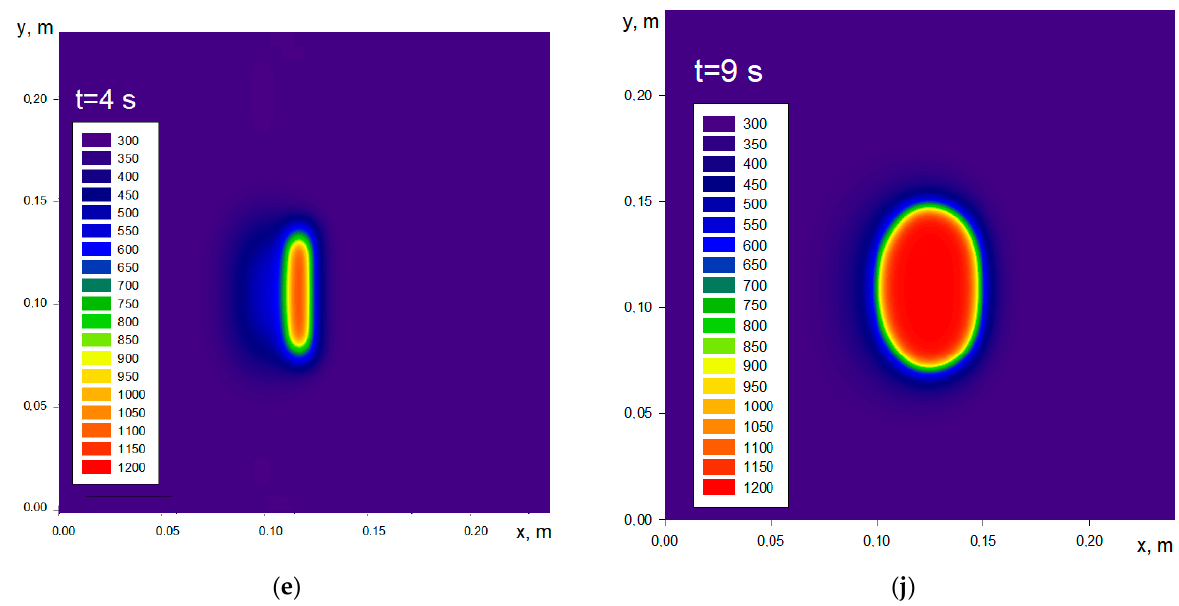
Figure 7. Isotherms on the wood layer surface at difference moment: L = 69 mm, d = 6.5 mm, h = 8.5 mm